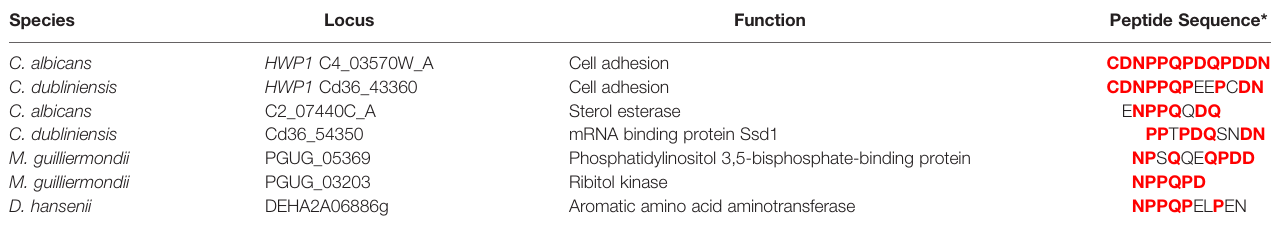
TABLE 2 | Best tblastn matches to the anti-Hwp1 MAb 2-E8 immunogen peptide among species closely related to C. albicans . Species